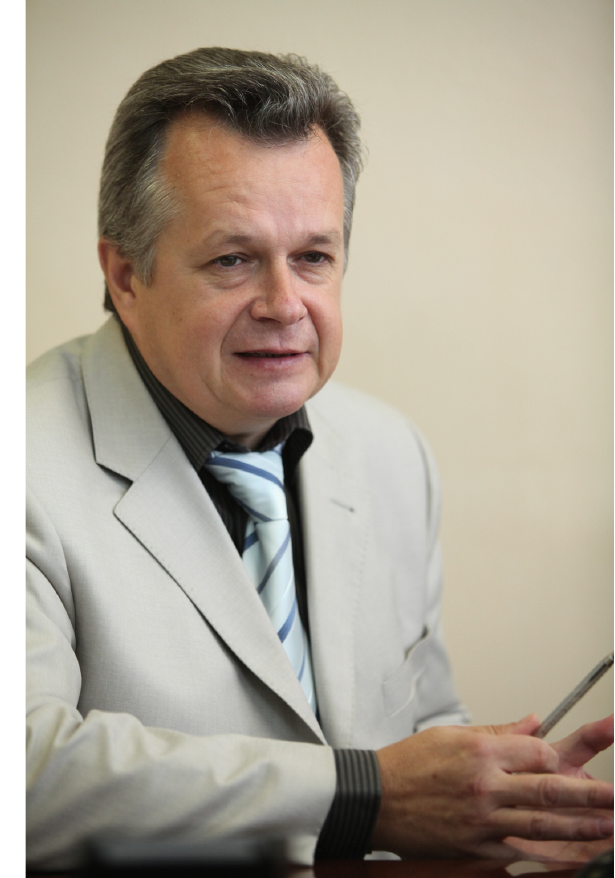
Figure 10. Prof. I. F.